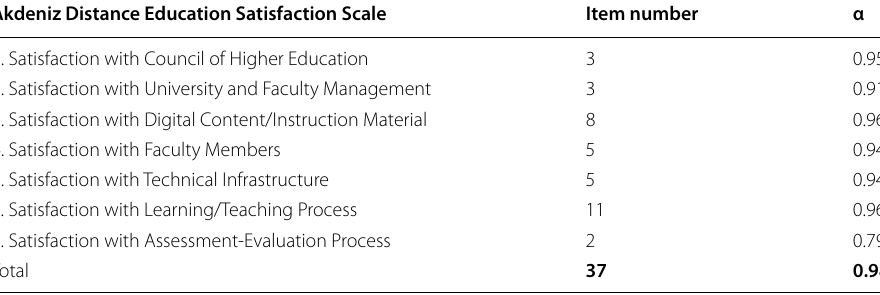
Table 1 Cronbach’s Alpha reliability coefficients of the scales Akdeniz Distance Education Satisfaction